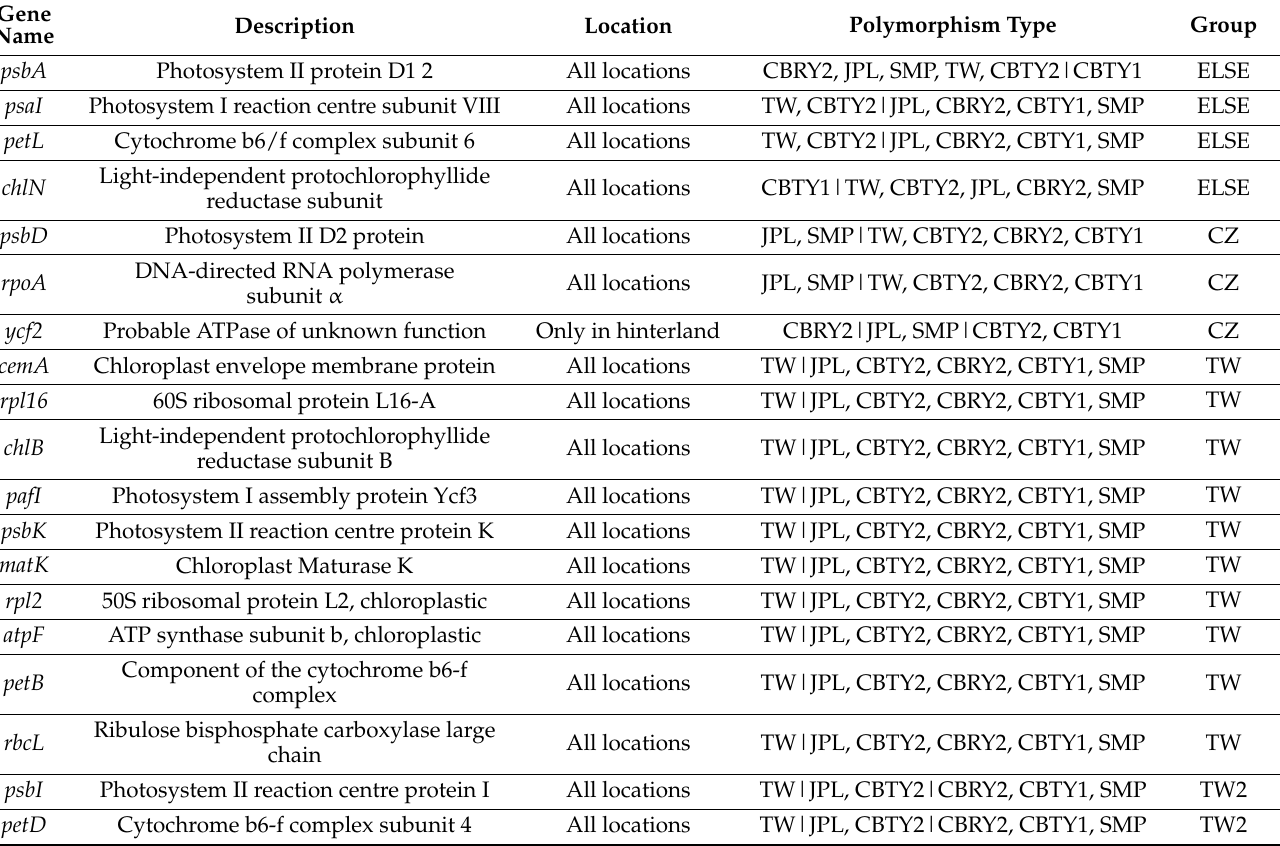
Table 2. Information regarding the polymorphic chloroplast genes between Cathaya argyrophylla populations located at six different locations in